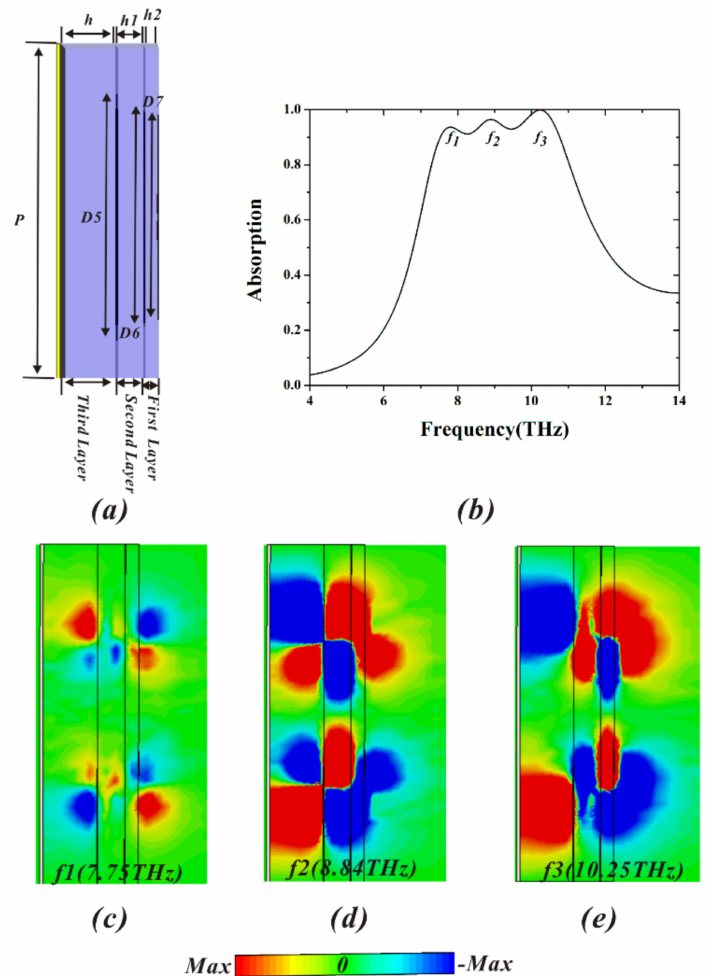
Figure 8. ( a ) Cross section of broadband MA, ( b ) absorptivity of broadband MA; distributions of y-component of magnetic field ( H y ) of three-layers structure for three resonance peaks on the cross section of y = 0: ( c ) 7.75 THz, ( d ) 8.84 THz, and ( e ) 10.25